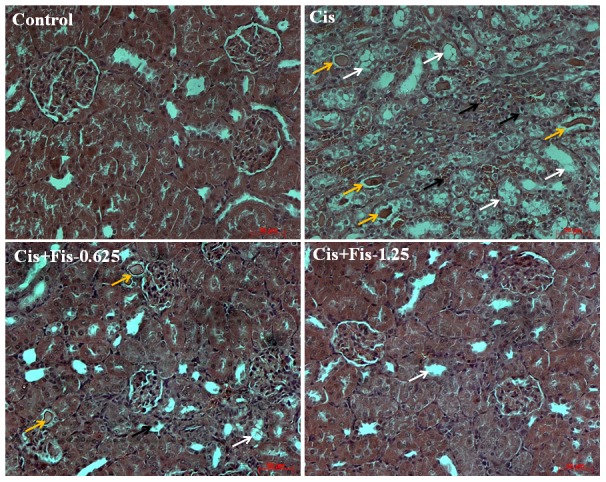
Histopathological observations of kidney tissues from rats treated with fisetin and cisplatin.Representative photomicrographs of kidney sections stained with Hematoxylin-eosin (H and E). Light microscopic examination of kidney sections from vehicle control rats (Control) showing normal glomeruli and tubules (X200 magnification, scale bar: 50 µm). Kidney tissue sections from cisplatin alone treated rats (Cis) showing severe tubular degeneration and necrosis (white arrow), infiltration of inflammatory cells (black arrow) and accumulation of homogenous eosinophilic casts (yellow arrow) in the lumen of the tubules (X200 magnification, scale bar: 50 µm). Kidney tissue sections from low dose of fisetin (0.625 mg/kg) plus cisplatin treated rats (Cis+Fis-0.625) showing recovery of tubular degeneration (white arrow), mild infiltration of inflammatory cells (black arrow) and decreased accumulation of eosinophilic casts in tubular lumen (yellow arrow) when compared to cisplatin alone treated rats (X200 magnification, scale bar: 50 µm). Kidney tissue sections from high dose of fisetin (1.25 mg/kg) plus cisplatin treated rats (Cis+Fis-1.25) showing predominantly normal renal histology with occasional degenerative changes (white arrow) when compared to cisplatin alone treated rats (X200 magnification, scale bar: 50 µm).